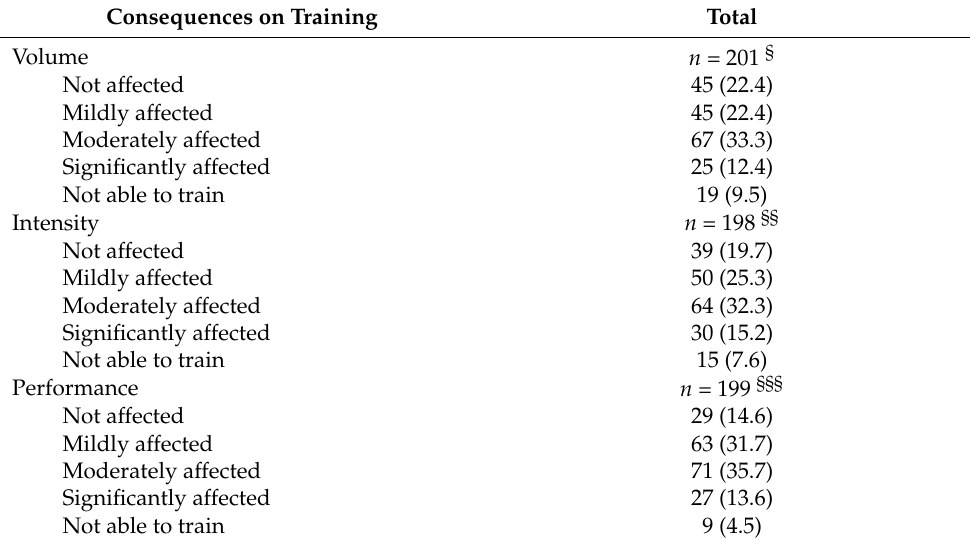
Table 2. Consequences on training and competition due to injury.